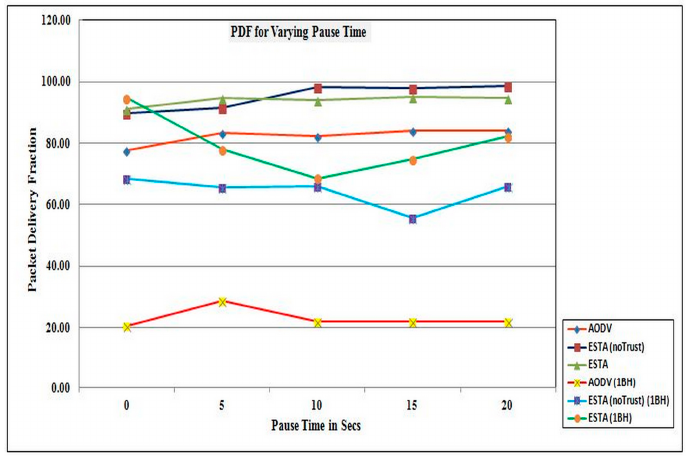
Figure 7. PDF for varying Pause